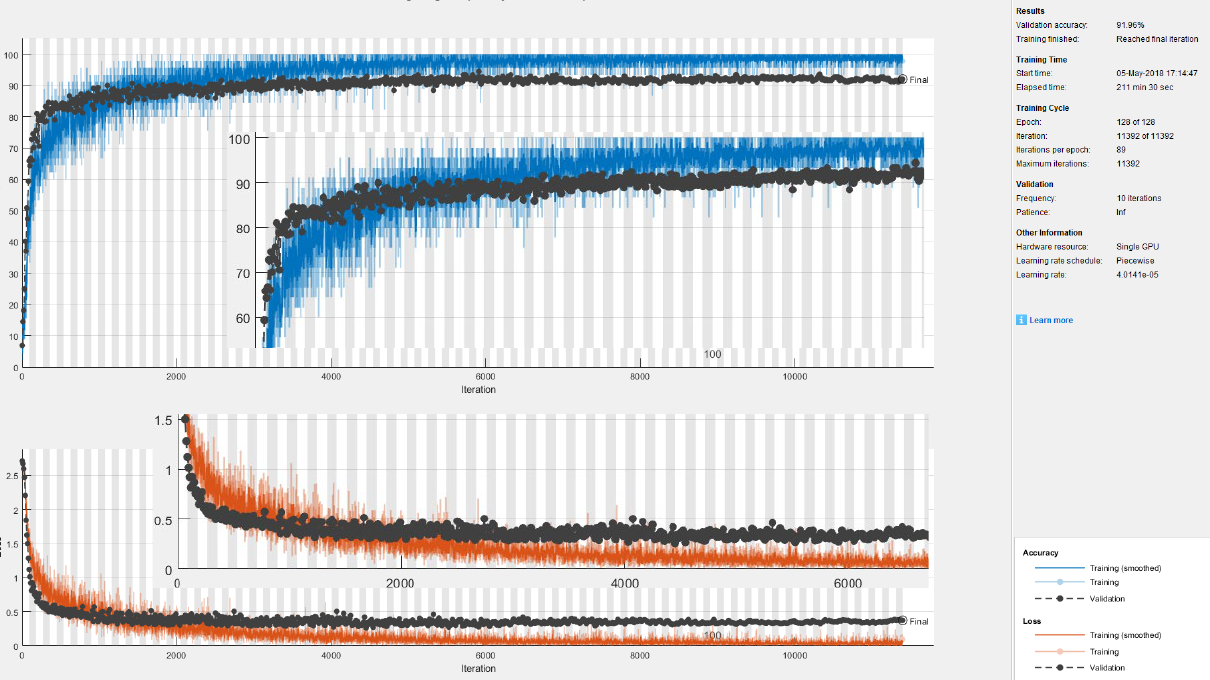
Fig. 9. The training progress for a truncated TLCNN with 384 and 192 filters in its 17 th and 20 th layers. High accuracies are achieved before the final